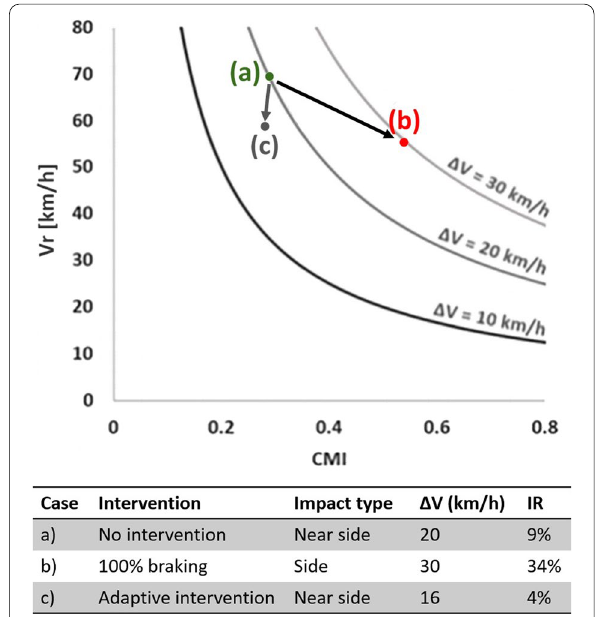
the CMI- V r plane with the associated values of impact type, (cid:31) V , and IR for vehicle A